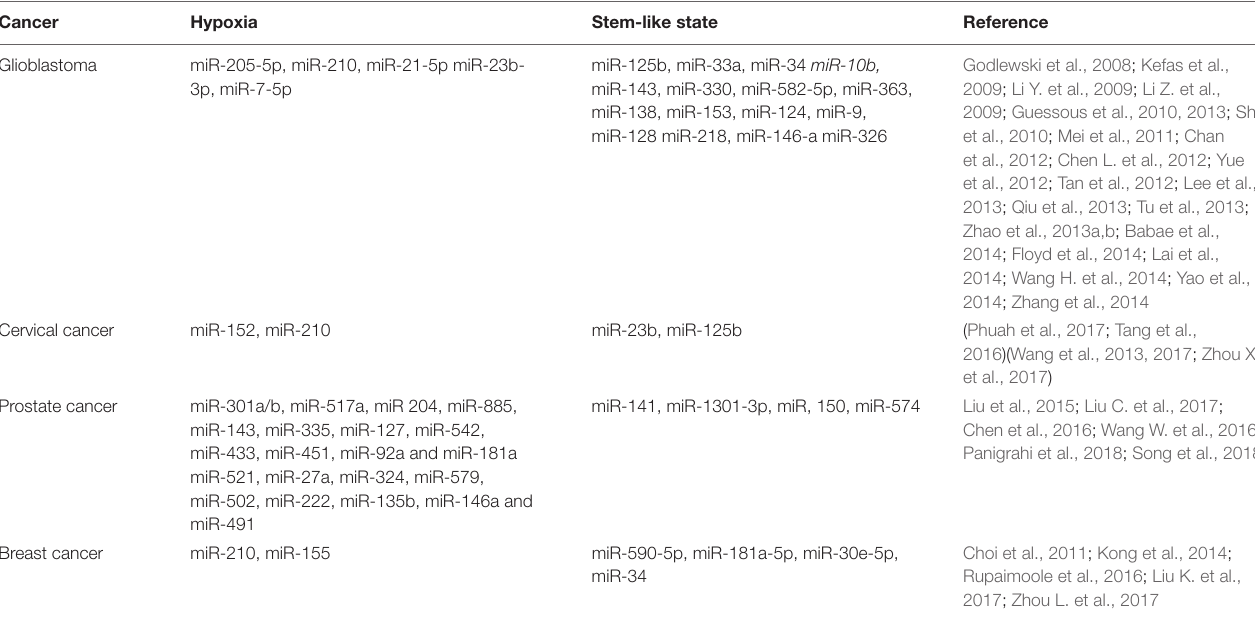
TABLE 1 | microRNAs associated with hypoxia and the stem-like state in four aggressive cancers.